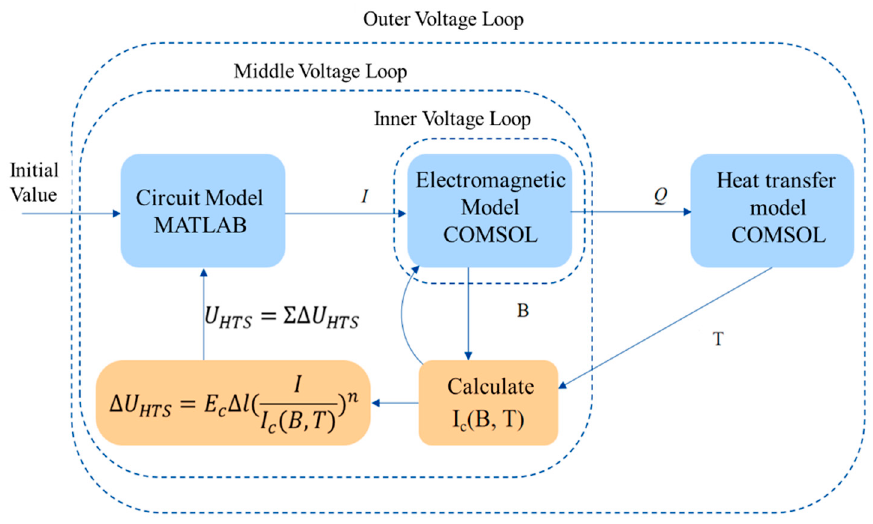
Figure 1. Schematic diagram of inductive superconducting fault current limiter (SFCL) transient-state simulation model.